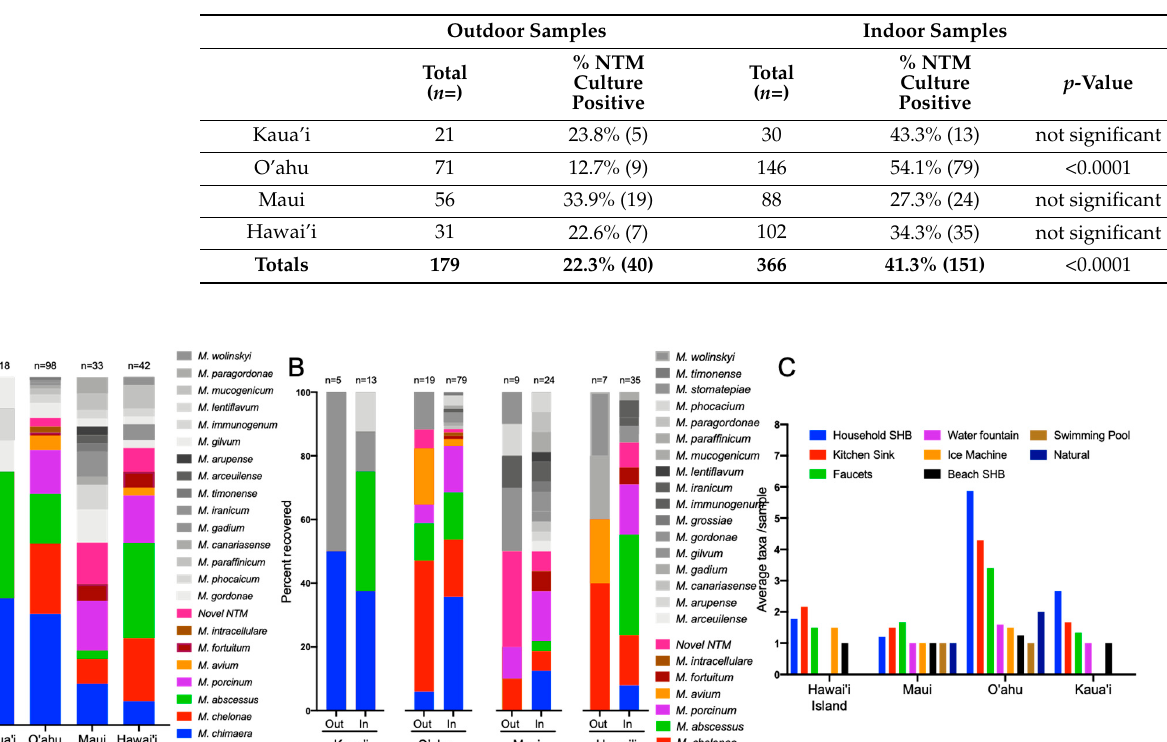
Table 4. NTM recovery per island between outdoor and indoor samples.